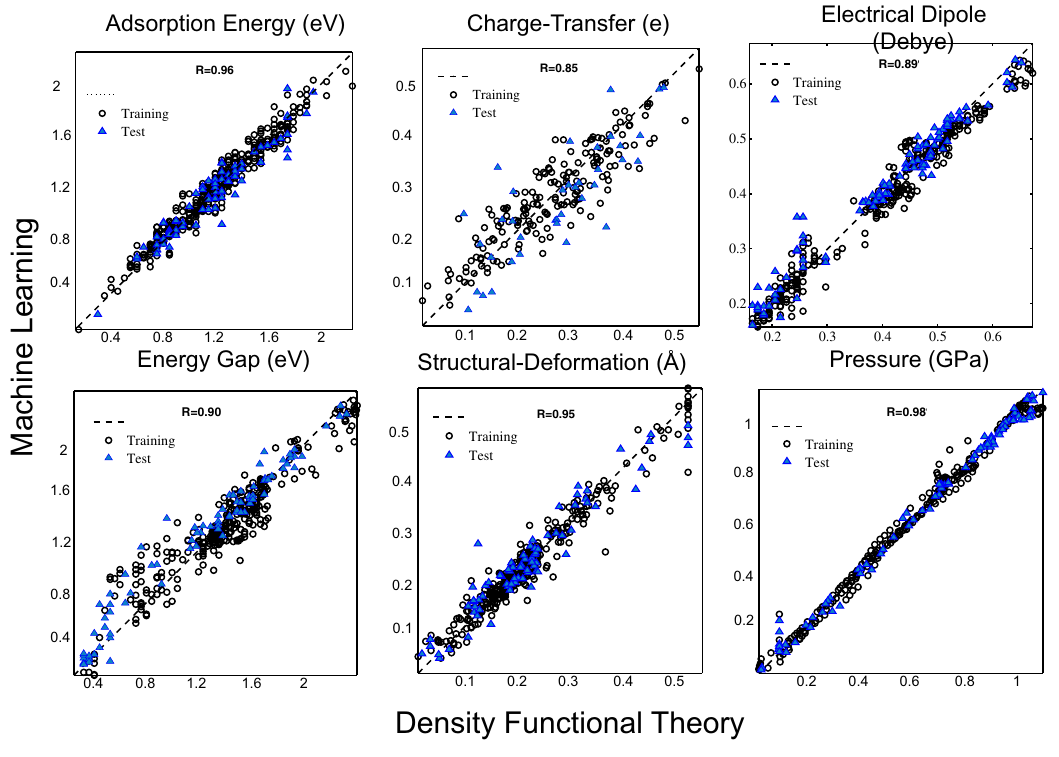
Figure 2. Learning performance of interfacial properties. Parity plots comparing interfacial properties of 4-block 1D chain polymer adsorbed on graphene (CPs/GE) computed using DFT against predictions made using machine learning algorithm. Pearson’s correlation value is indicated in each panel, showing the agreement between training and test set data, which the test data is for 8-block 1D chain